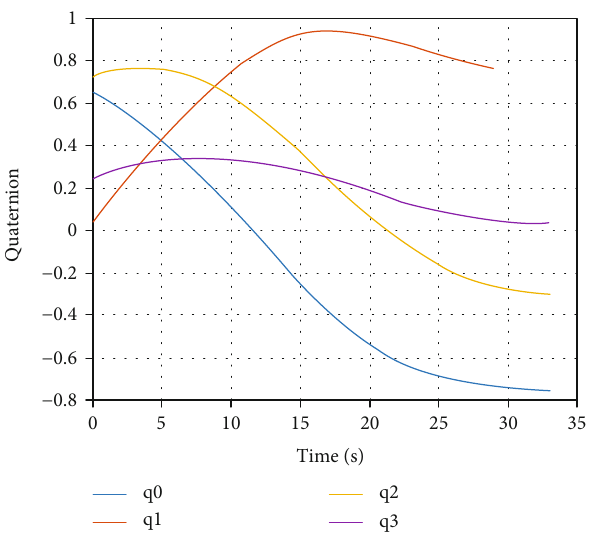
Figure 12: Attitude quaternion time history based on the grey wolf optimizer.